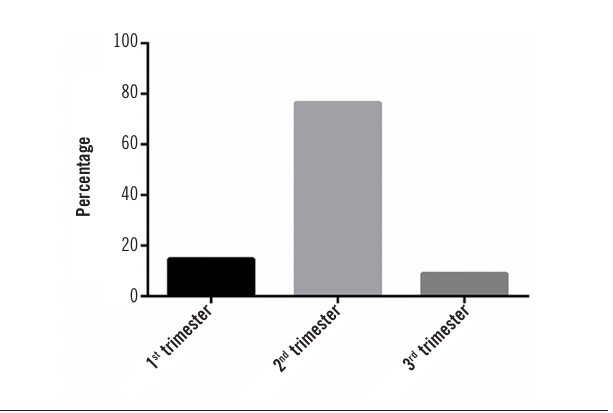
FIGURE – Visual demonstration of the percentages of confirmed cases of umbilical cord constrictions during the trimesters of pregnancy